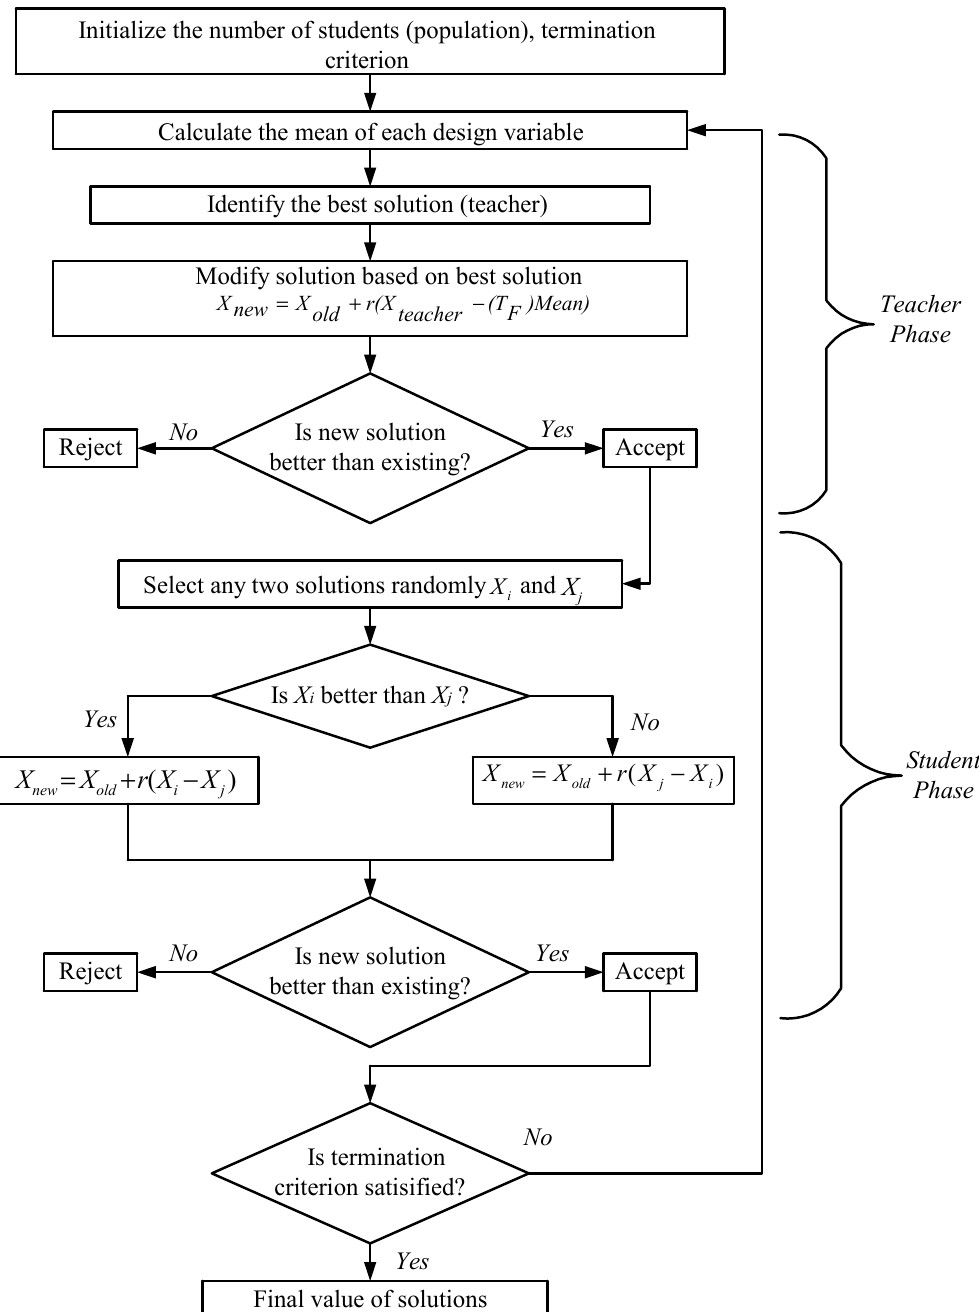
Figure 4. Flowchart of teaching–learning-based optimization (TLBO) technique.